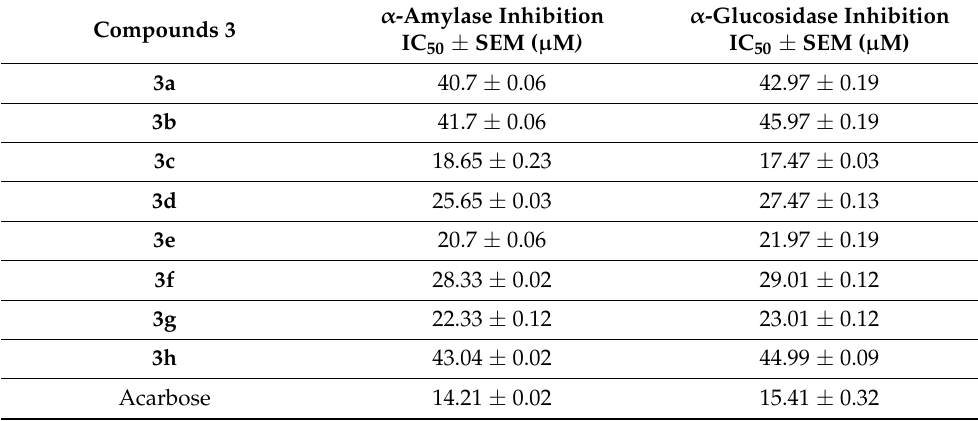
Table 3. α -amylase and α -glucosidase inhibition activity of benzimidazole-urea 3a-h . Compounds